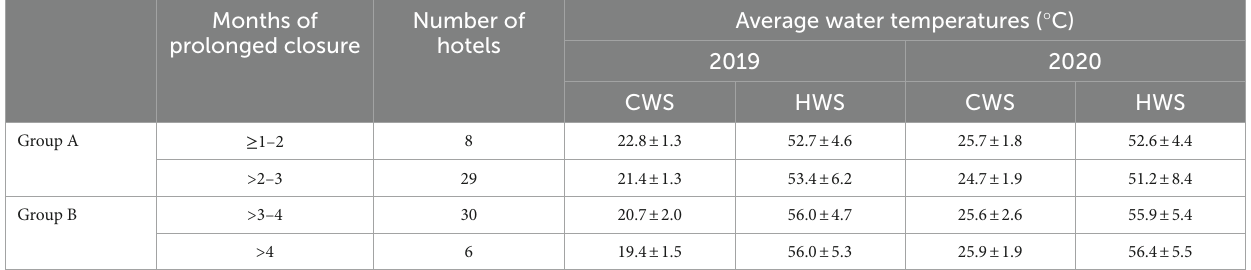
TABLE 1 Prolonged closure periods in 2020 of Groups A and B and average water temperatures of the samples taken in 2019 and 2020 (CWS = cold water system; HWS = hot water system).